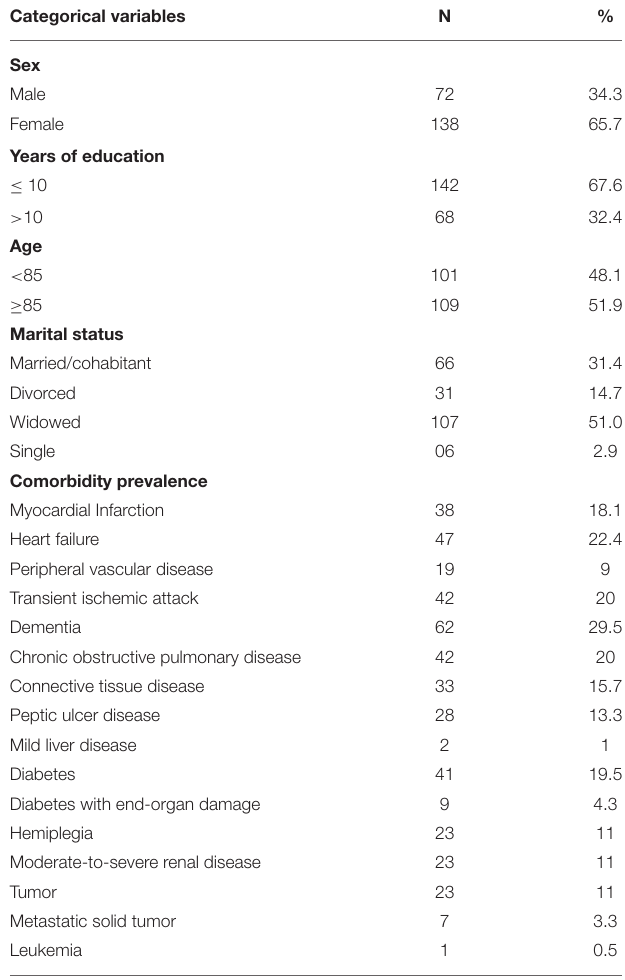
TABLE 1 | Sex, years of education, marital status and comorbidities of the participants. Categorical